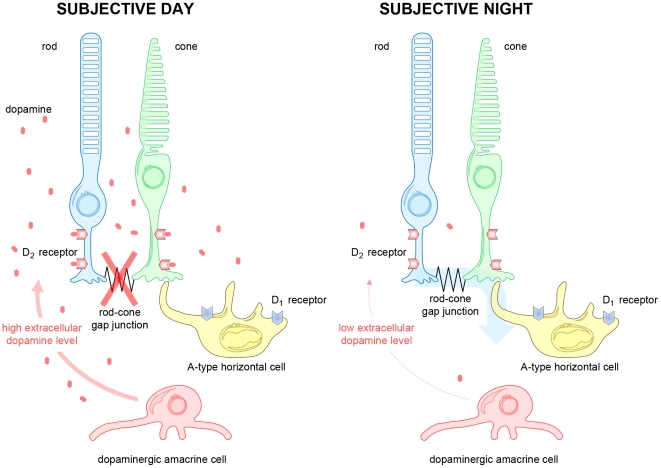
Schematic representation of circadian clock control of a neural pathway in the mammalian retina.The retinal clock increases dopamine release in the subjective day so that the dopamine D2 receptors on rods and cones are activated. This in turn greatly reduces the conductance of the gap junctions between rods and cones so that rod input to cones and cone-connected (e.g. axonless A-type) horizontal cells is minimal. In contrast, during the subjective night the retinal clock decreases endogenous D2 receptor activation, so that the conductance of rod-cone gap junctions is strong. As a result, under dark-adapted conditions dim light (scotopic range - see definition in Materials and Methods) stimuli evoke responses from rods, cones and cone-connected horizontal cells at night, but evoke responses only from rods in the day.